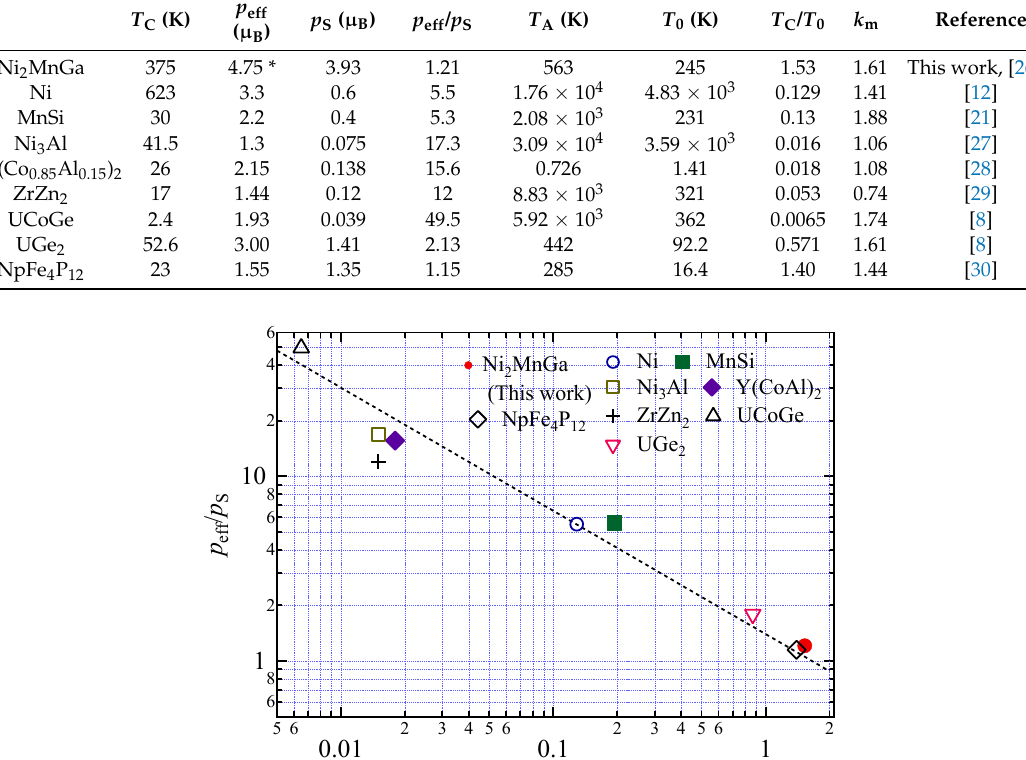
Table 2. Basic magnetic parameters and k m , as obtained from Equation (10).